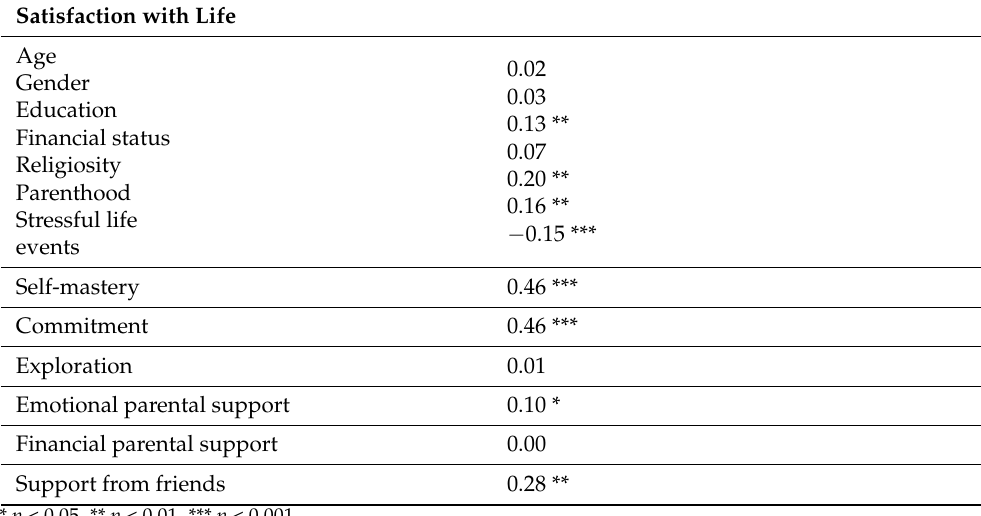
Table 2. Pearson Correlations between Independent Variables and Satisfaction with Life.